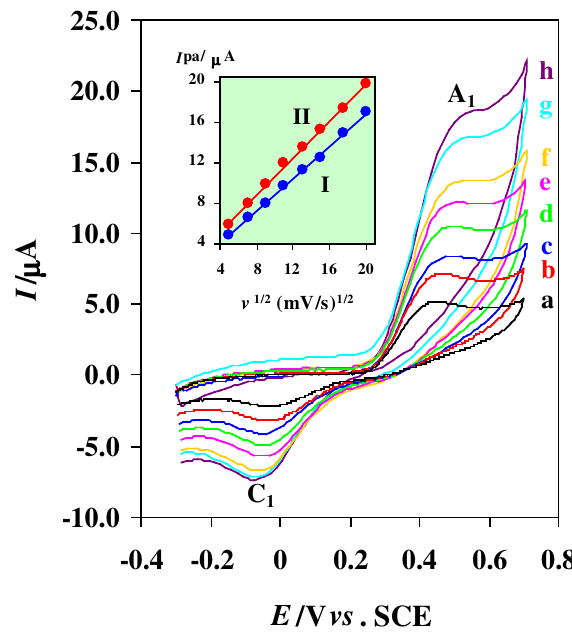
Figure 2. Typical voltammograms of 0.75 mM of thiourea at bare Pt electrode (2 mm diameter) in acetate buffer solution (C = 0.15 M, pH = 4.5) at various scan rates. Scan rates from (a) to (h) are: 25, 50, 80, 120, 170, 225, 306 and 400 mV/s, respectively . Inset: variation of anodic peak current (Ipa) versus square root of scan rate; (I) at bare Pt electrode, (II) at alumina Pt modified electrode. T = 25 – 1 o